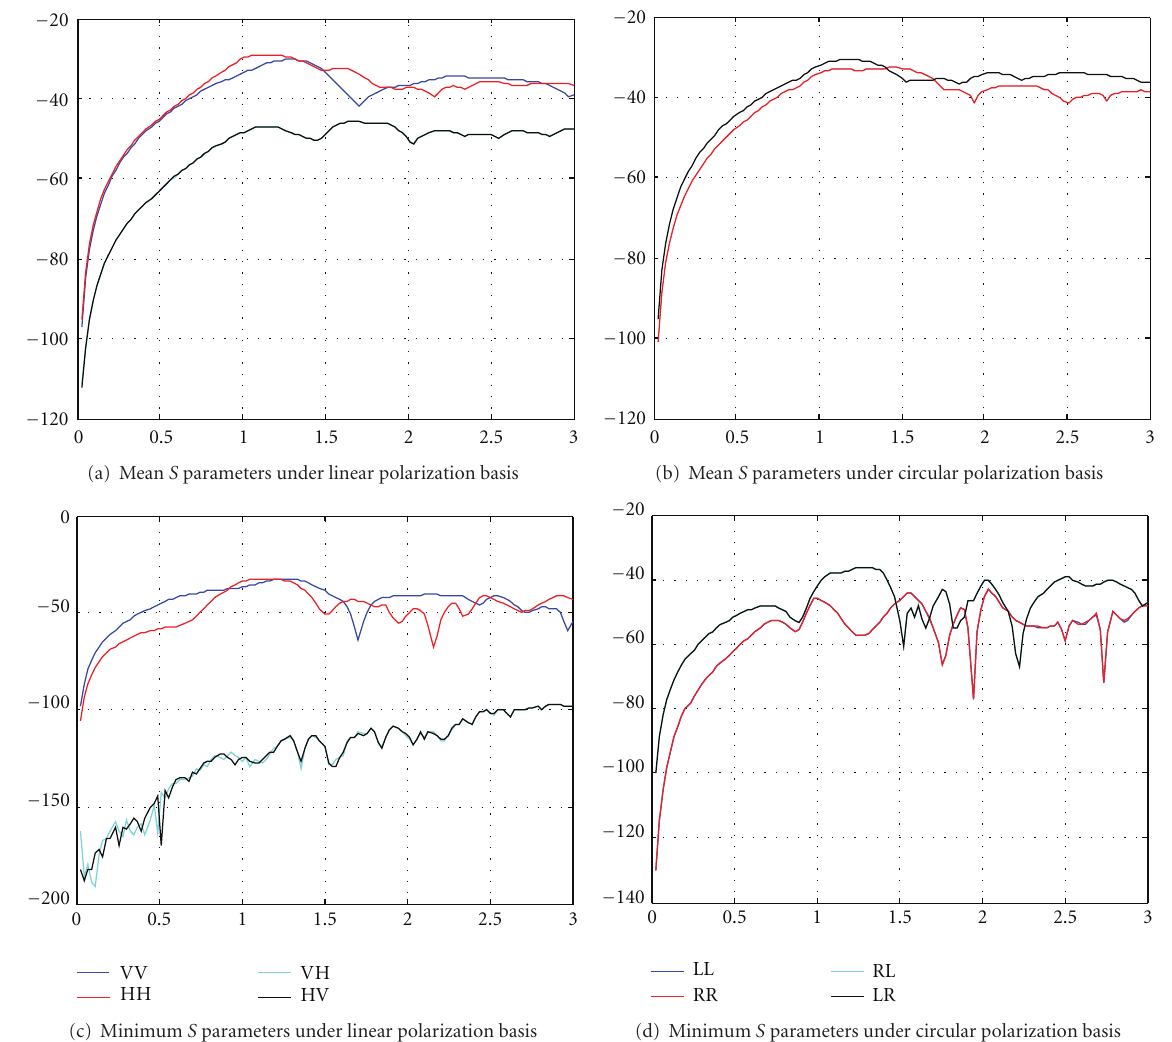
Figure 11: S AB ,mean ( f ) and S AB ,min ( f ) for the scattering problem of the breast volume with a 5mm tumor with the dielectric properties of σ = 0 . 1 S/m. (a) S f ) for linear polarization states, (b) S ε r = 15, AB ,mean ( polarization states and (d) S AB ,min ( f ) for circular polarization